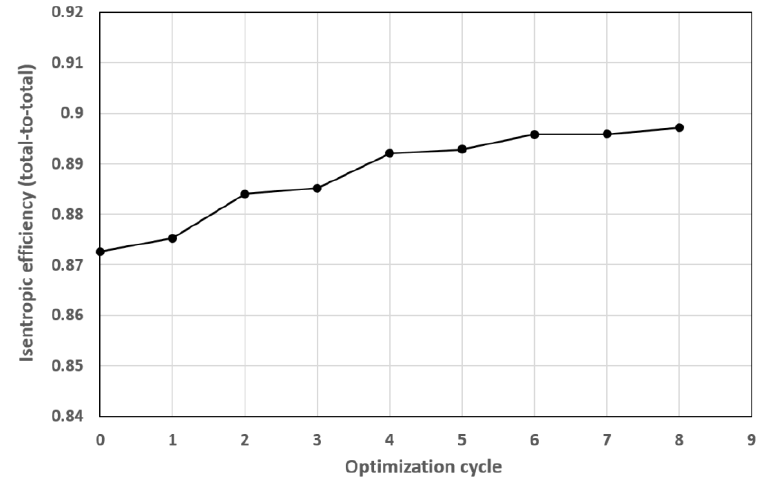
Figure 11. Isentropic total-to-total efficiency of expander by shape optimization without assuming the extra mechanical losses.